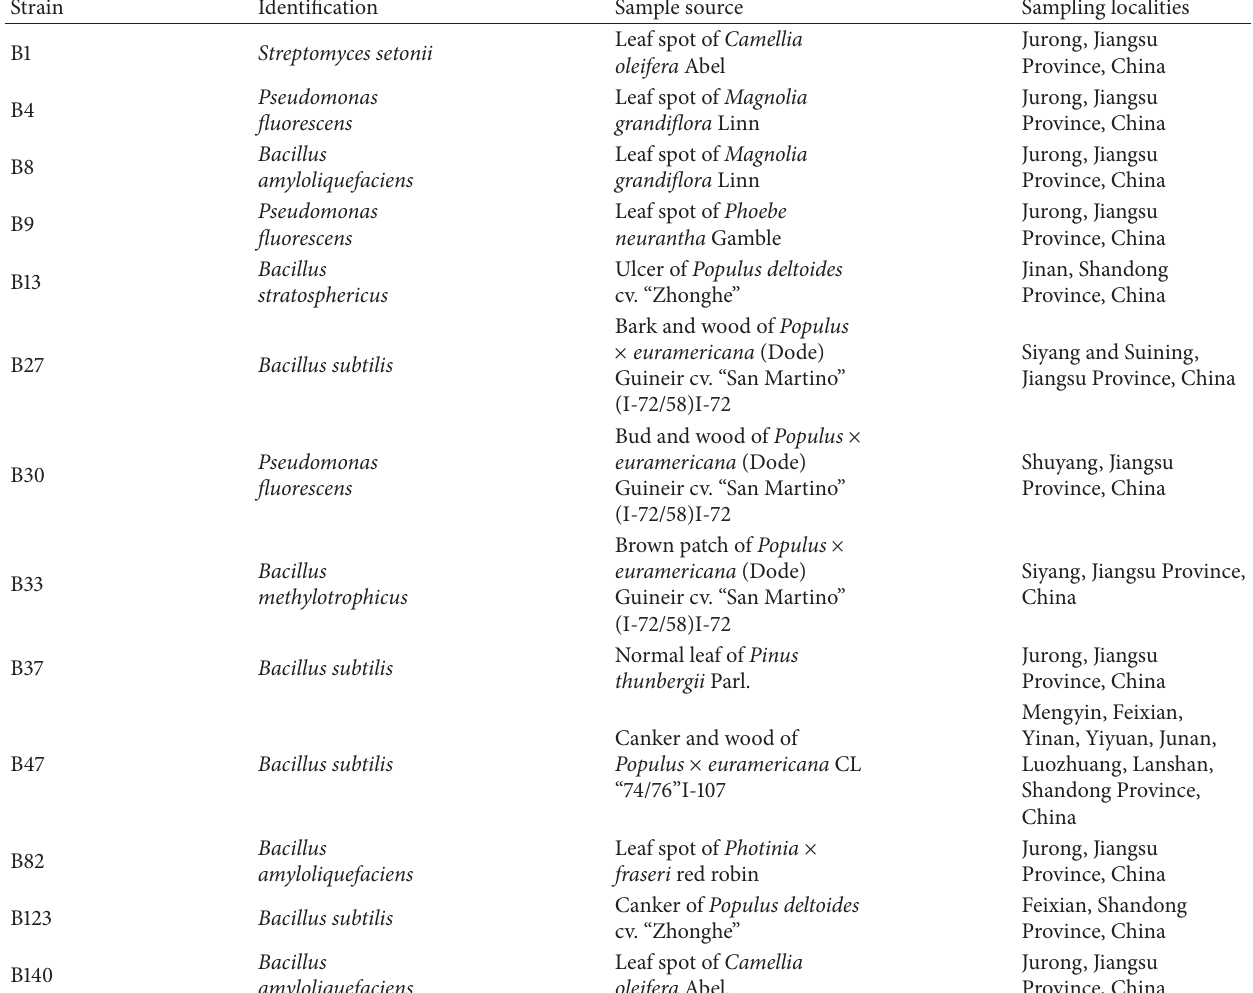
Table 2: The source of 13 biocontrol